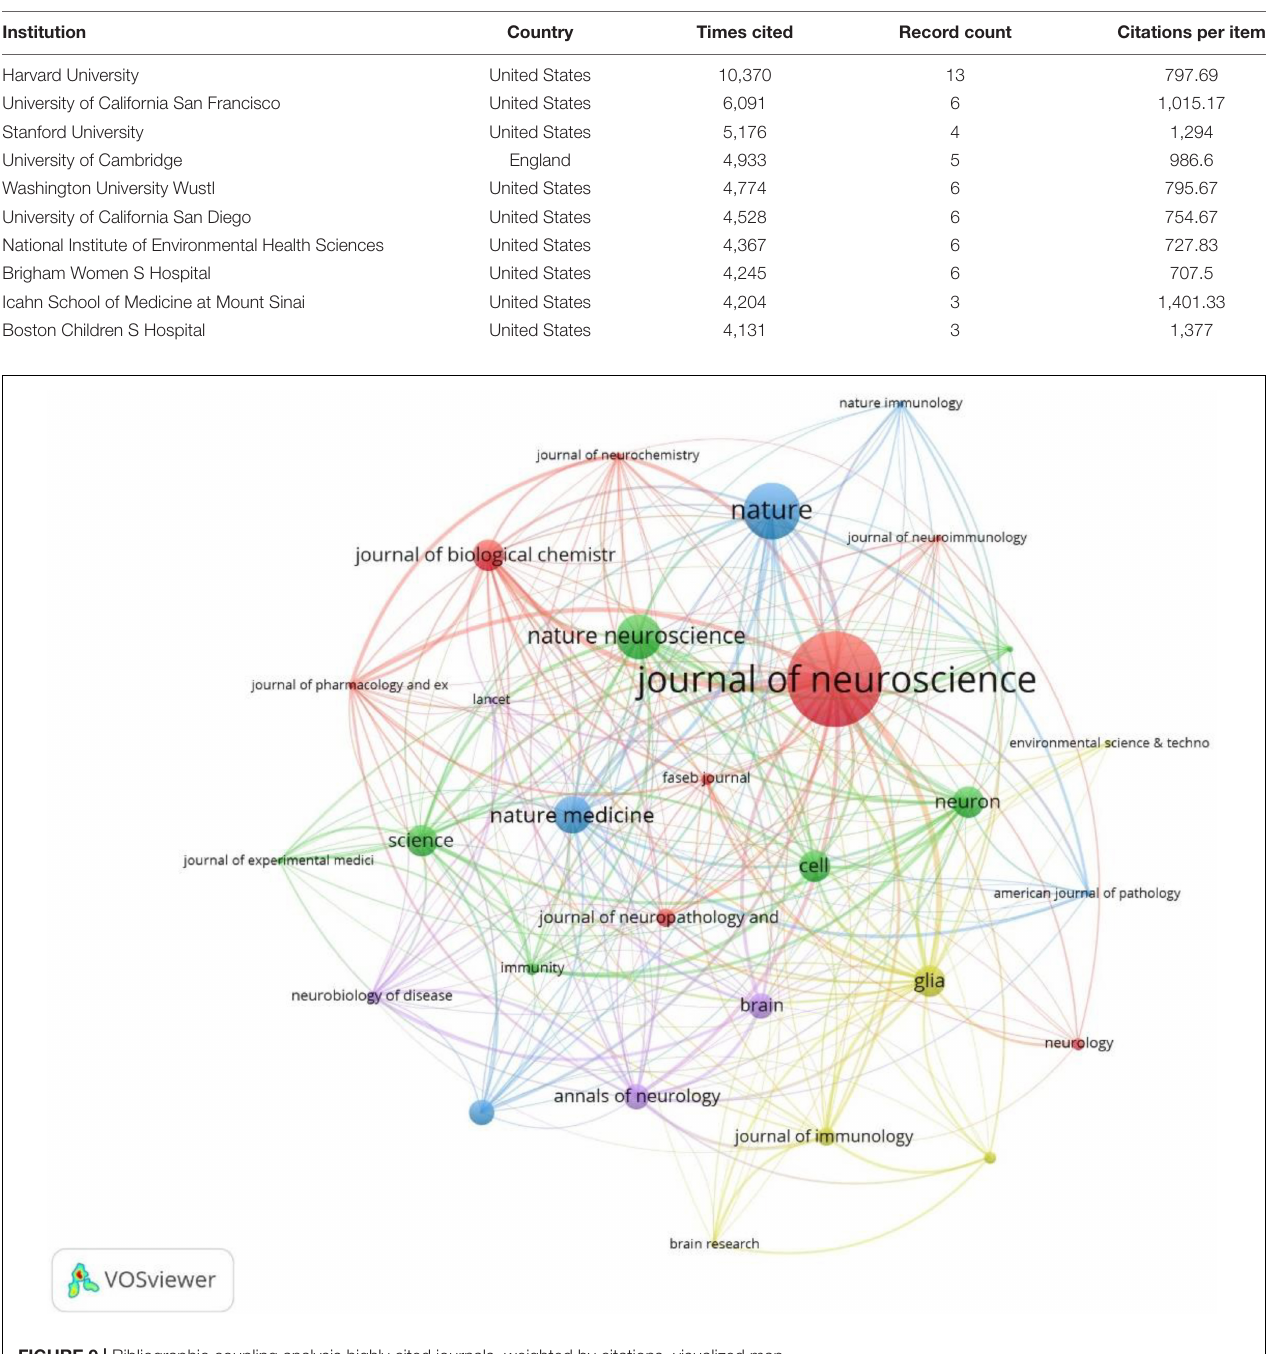
TABLE 4 | List of the top 10 cited institutions.